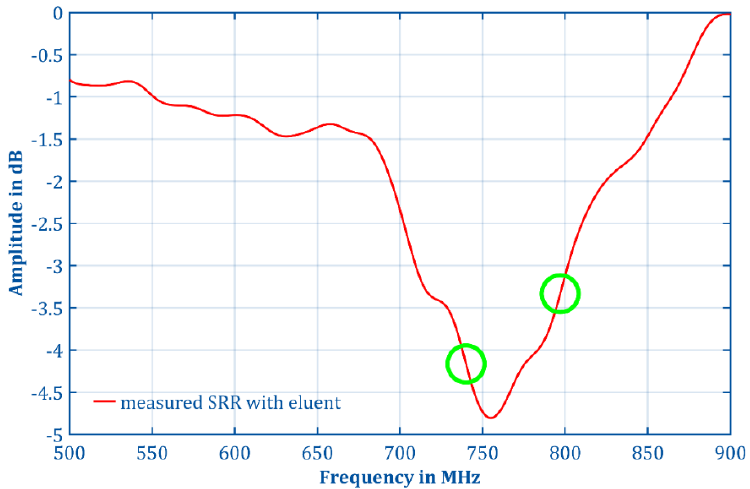
Figure 10. Measured transmission response (red) of the CaSRR loaded with the eluent and recorded with the new readout electronics. The resonance frequency was 755 MHz for the used eluent consisting of 25% ultrapure water and 75% acetonitrile, and the attenuation was − 4.806 dB. The green circles mark the optimum excitation frequencies at 740 MHz and at 797 MHz for highest sensitivity regarding the detection of resonance frequency shifts.